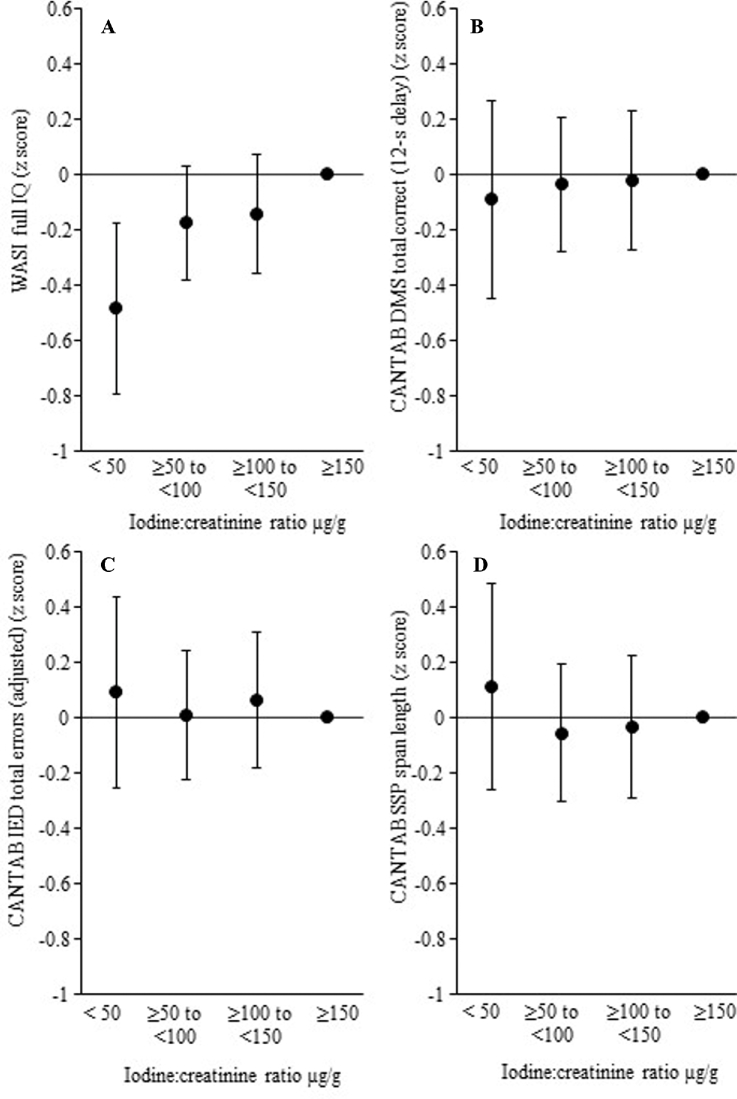
Adjusted differences in cognitive function at 6–7 y in 654 chidren in the Southampton Women's Survey, according to maternal preconception iodine status (iodine:creatinine ratio). Numbers of mother-child pairs—iodine:creatinine ratio: <50, n = 58; ≥50 to <100, n = 222; ≥100 to <150, n = 188; ≥150, n = 186. Cognitive function assessed using the WASI (22) (A) and Cambridge Neuropsychological Test Automated Battery (CANTAB, Cambridge Cognition, Cambridge, United Kingdom) (23) (B–D); data adjusted for maternal IQ, maternal education, prepregnancy BMI, duration of breastfeeding, smoking in pregnancy, sex, and age (for CANTAB outcomes); reference group iodine:creatinine ratio: ≥ 150µg/g; values are means and 95% CIs. IED adjusted by adding 25 for each stage not attempted due to failure. CANTAB, Cambridge Neuropsychological Test Automated Battery; DMS, Delayed Matching to Sample; IED, Intra-Extra Dimensional Set Shift; SSP, Spatial Span; WASI, Wechsler Abbreviated Scale of Intelligence.